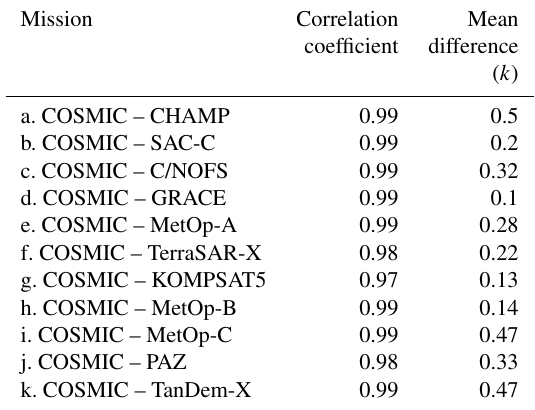
Table 1. Intercomparison of collocated GNSS profile